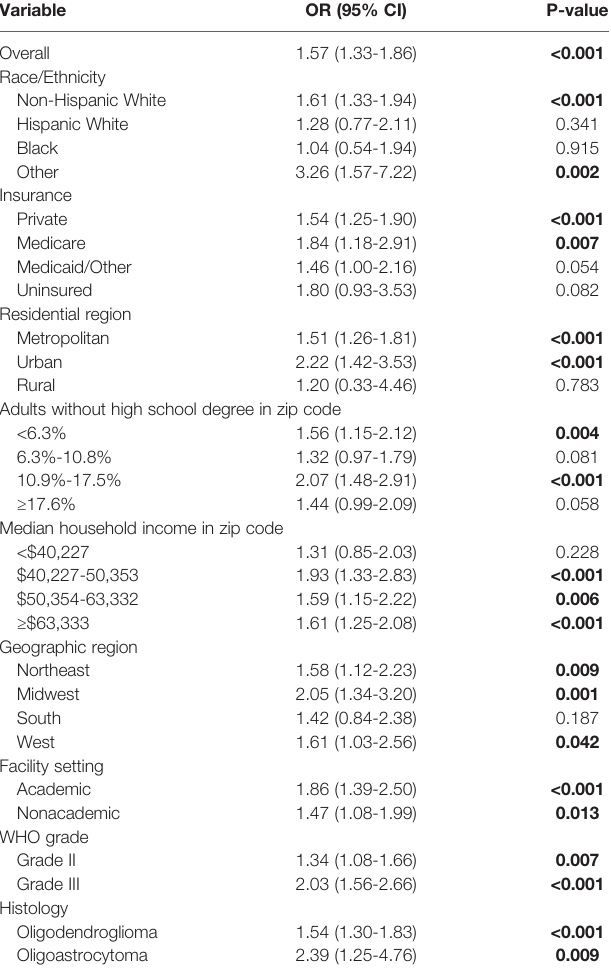
TABLE 5 | Adjusted odds of a reported test for patients diagnosed in 2017 versus